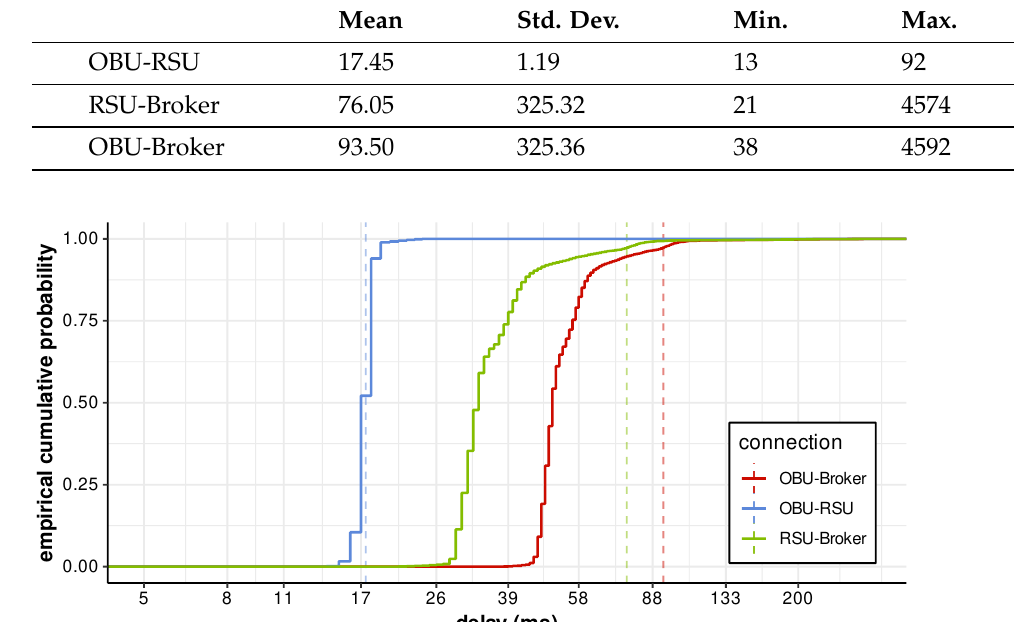
Figure 11. Empirical CDF representation of the OBU (Facilities layer) to RSU (Facilities layer) to cloud broker (listening client) message delay with the RSU with an LTE connection to the Internet. The vertical dashed lines represent average